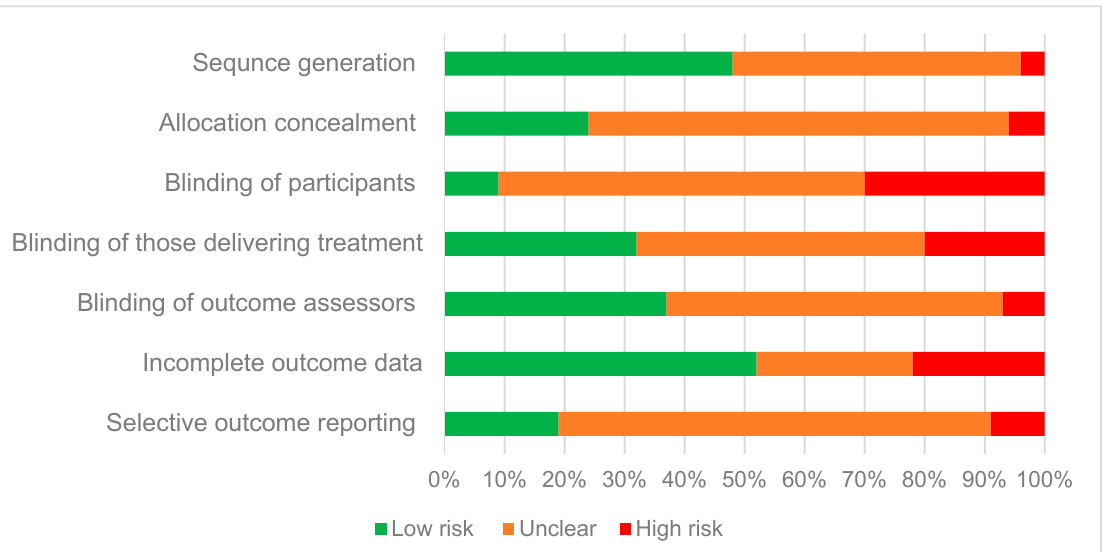
Figure 2. Percentage of studies from risk of bias assessment that were categorised as low, high or unclear risk for individual risk components.